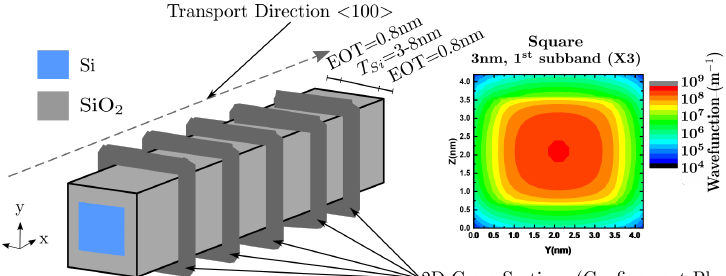
Figure 2. Coupling the 2D solution of the Schrödinger equation in multiple slices to a 3D Poisson solution in a structure based on a Si gate-all-around nanowire channel